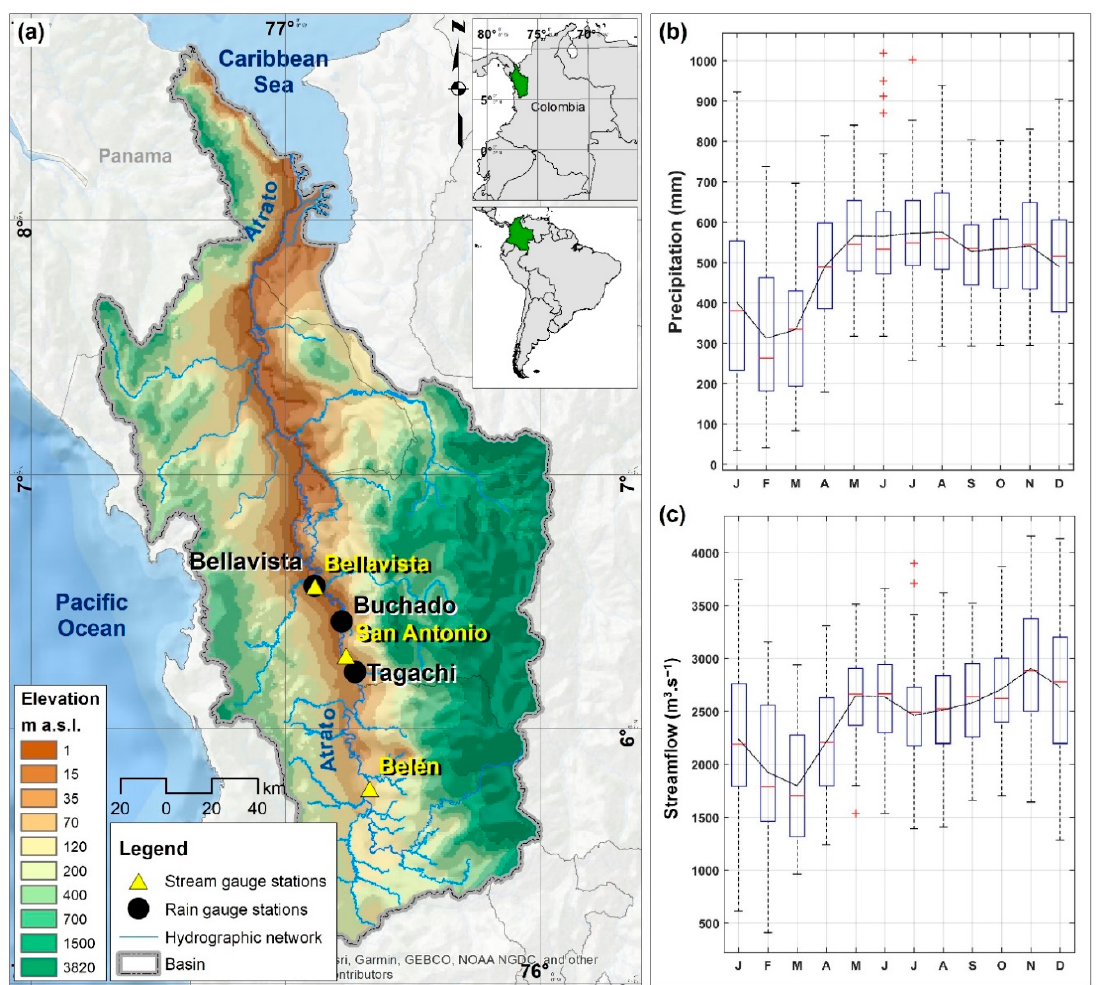
Figure 1. ( a ) Atrato River basin, ( b ) annual cycle of the precipitation, and ( c ) annual cycle of the streamflow during 1965–2015.